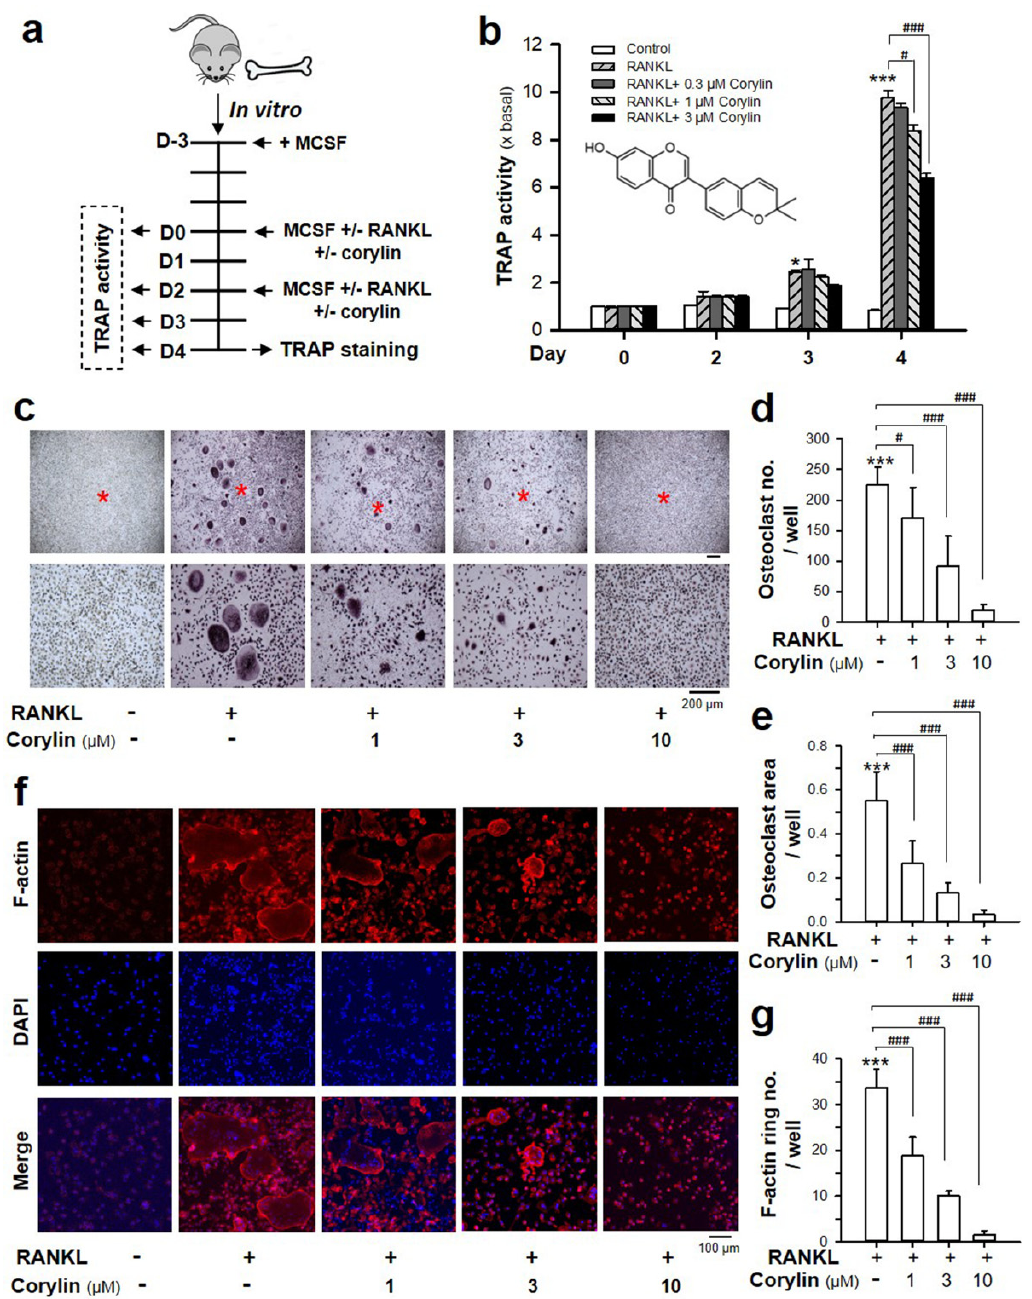
Figure 1. ( a ) Chemical structure of corylin. Cell viability of ( b ) cultured bone marrow macro- phages or ( c ) RAW 264.7 cells treated with corylin for 24 h and 48 h, respectively. Data represent the mean ± SD, n = 4, each with triplicate samples. p < 0.05, compared with control.